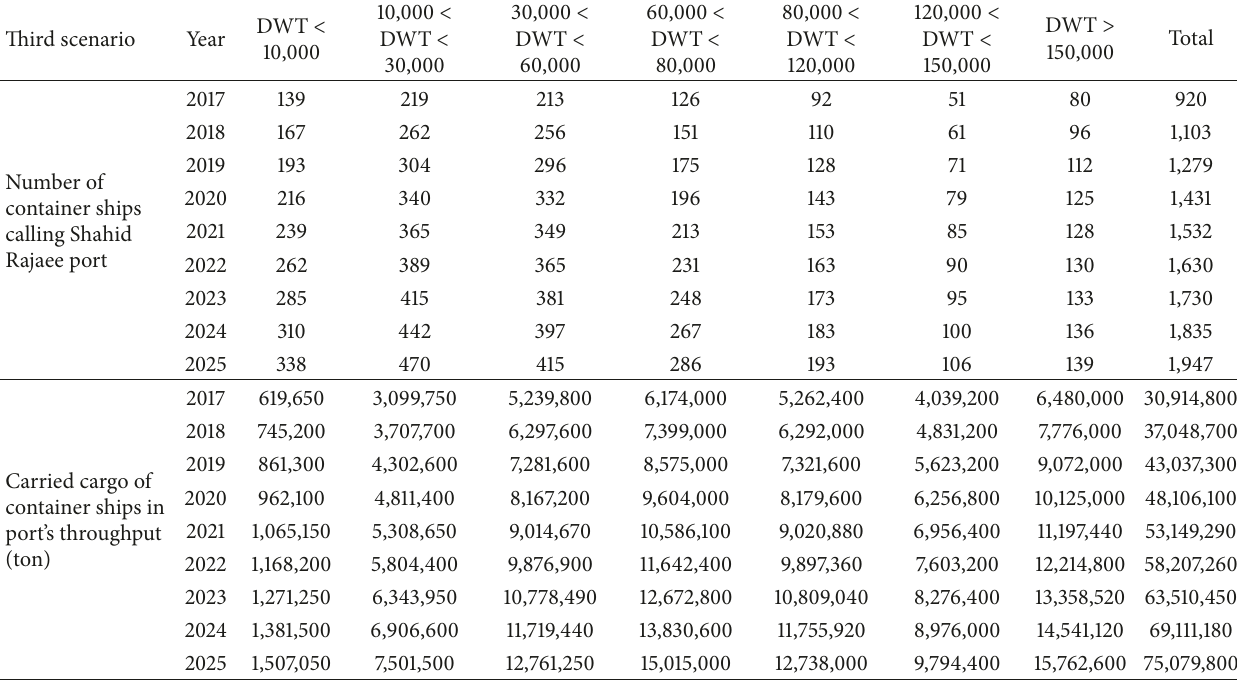
Table 5: Number of container ships and their carried cargo (ton) in port container throughput (predicted from 2017 to 2025) based on the third scenario